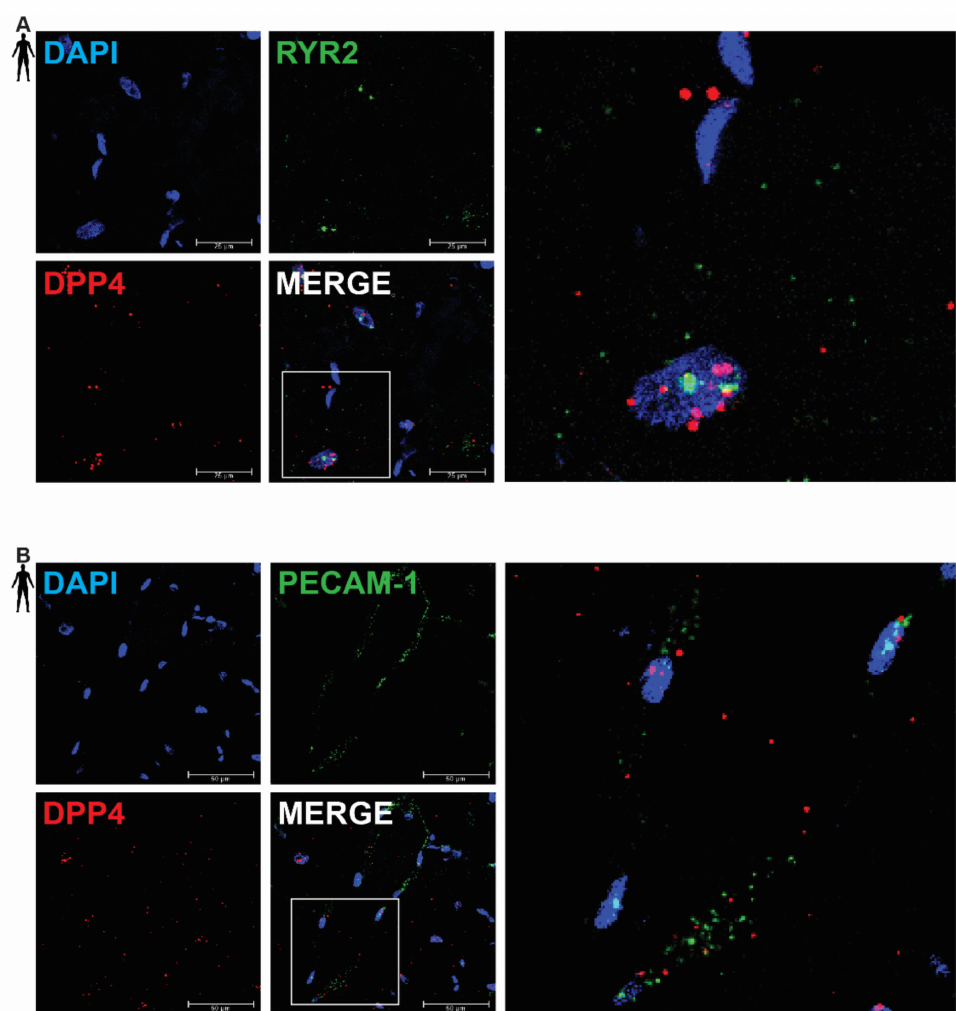
Figure 2. Representative confocal microscopy images of RNA Scope ® -DPP4 mRNA expression in human control left ventricle. Nuclei were stained with DAPI (blue). Fluorescein-labeled tyramide (green) was used to visualize mRNA of RYR2 (cardiomyocyte marker, ( A )) or PECAM-1 (endothelium marker, ( B )) and Cy3-labeled tyramide (red) was used to visualize mRNA of DPP4, respectively. Scale bar represents 25 or 50 µ m. (RYR2: ryanodine receptor 2, PECAM-1: platelet endothelial cell adhesion